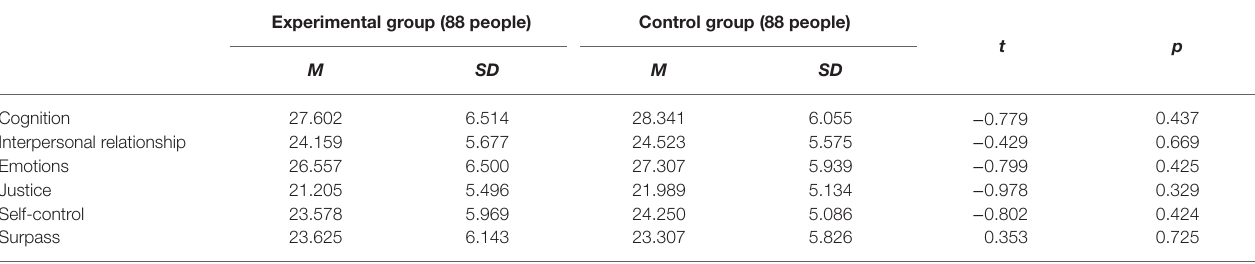
TABLE 4 | Comparison of pre-test differences between experimental group and control group. Experimental group (88 people)